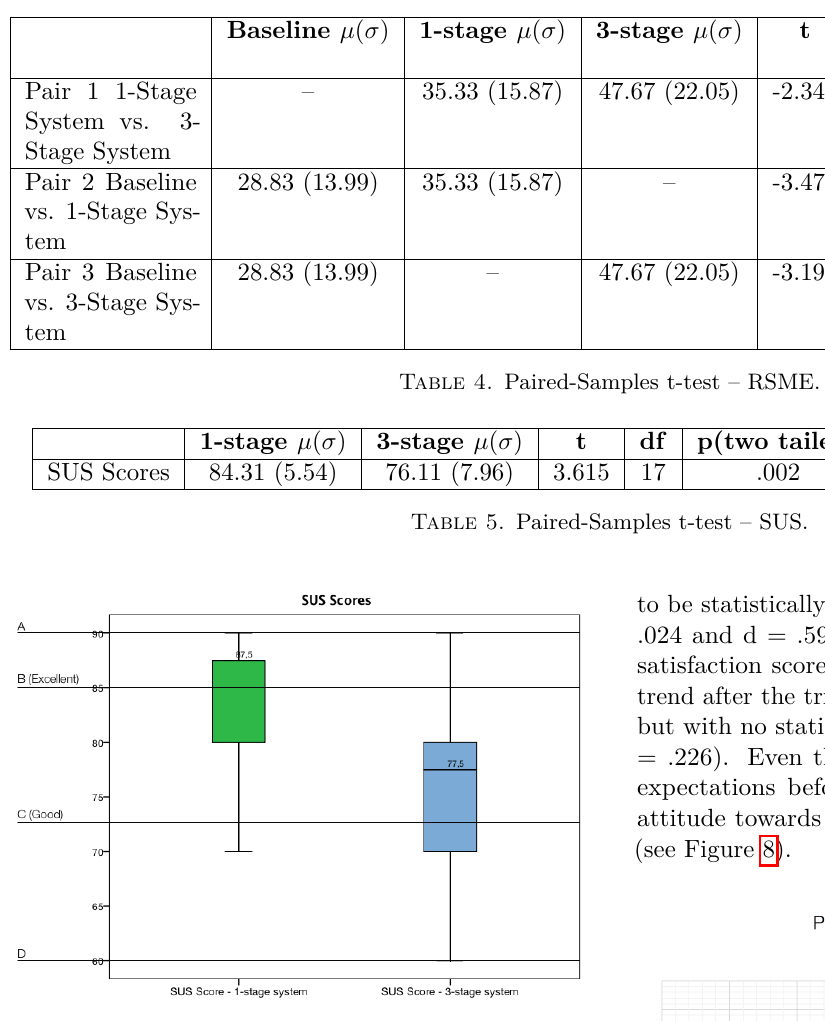
Figure 7. SUS Scores.